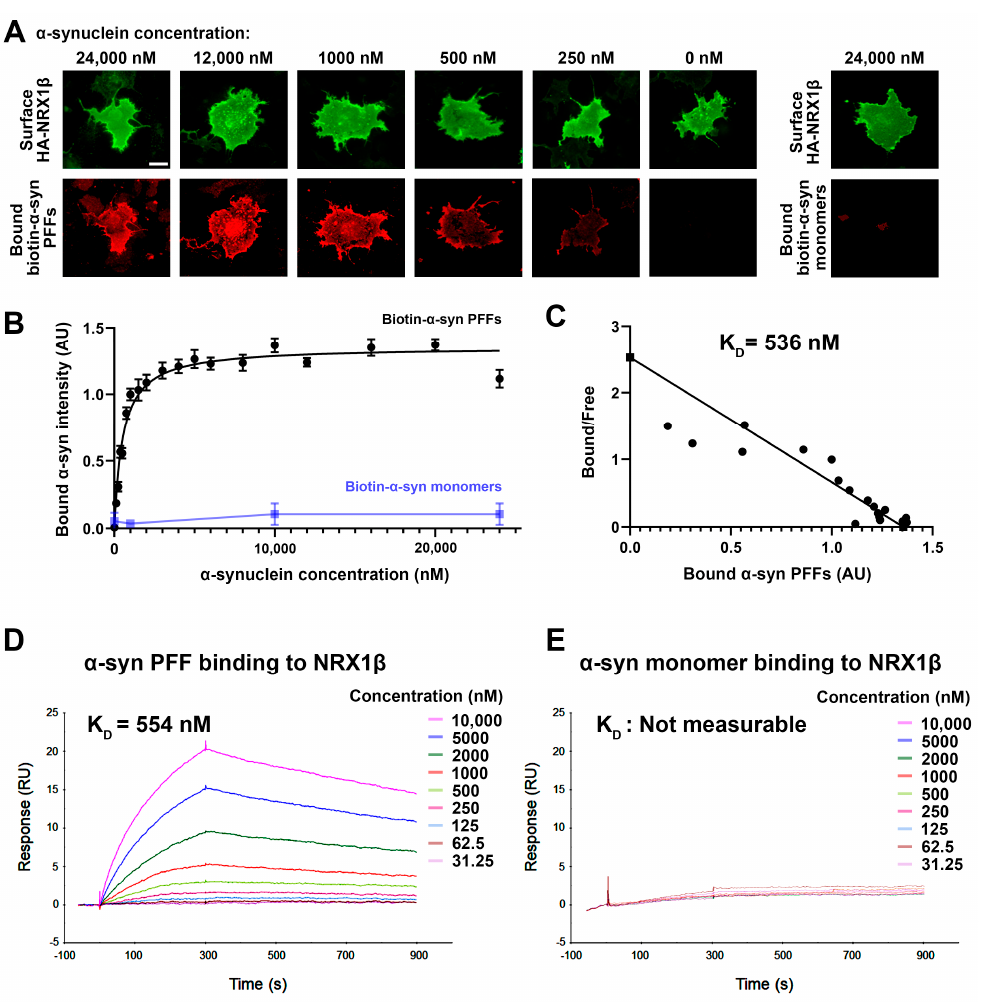
Figure 3. α -syn PFFs, but not α -syn monomers, bind directly to NRX1 β . ( A ) Representative